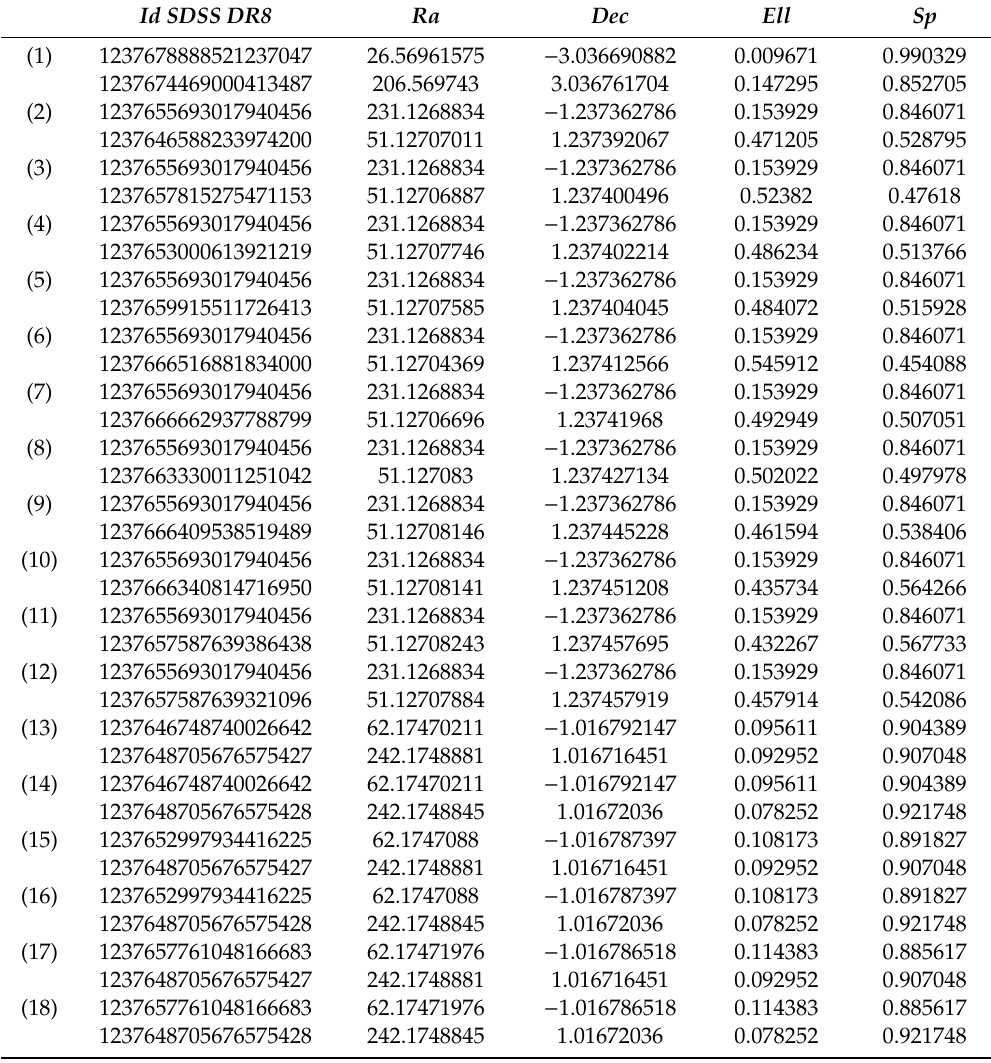
Table A4. Pairs of galaxies for the e ff ect of cosmic lens [40]. Id SDSS DR8—objID identification